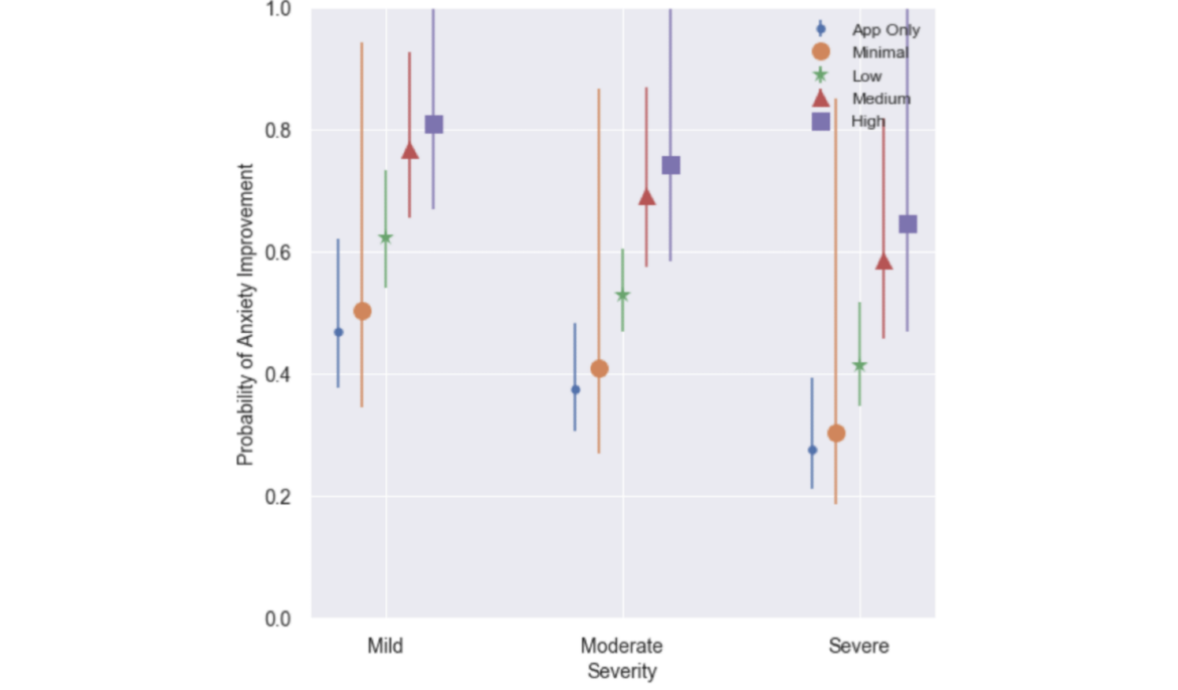
Figure 4. Probability of anxiety improvement by utilization and intake severity among the combined-care cohort (n=326). Shapes represent the expected mean probability of improvement by modality and intake severity; lines represent the corresponding 95% confidence